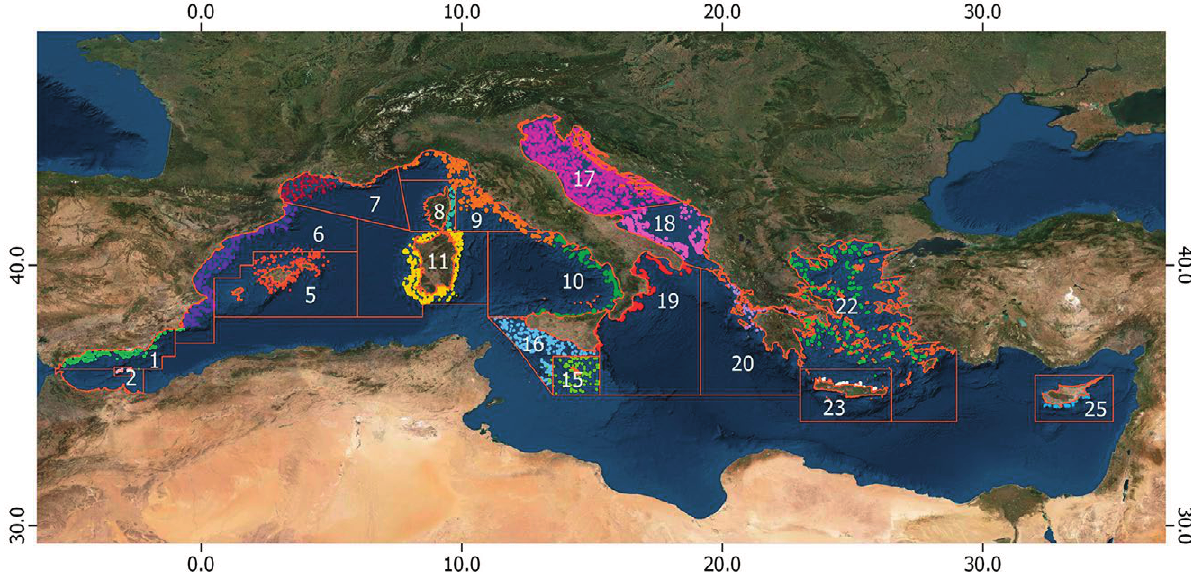
Fig. 1. – Study area of the MEDITS bottom trawl surveys, showing the hauls allocated to the geographical sub-areas established by the General Fisheries Commission for the